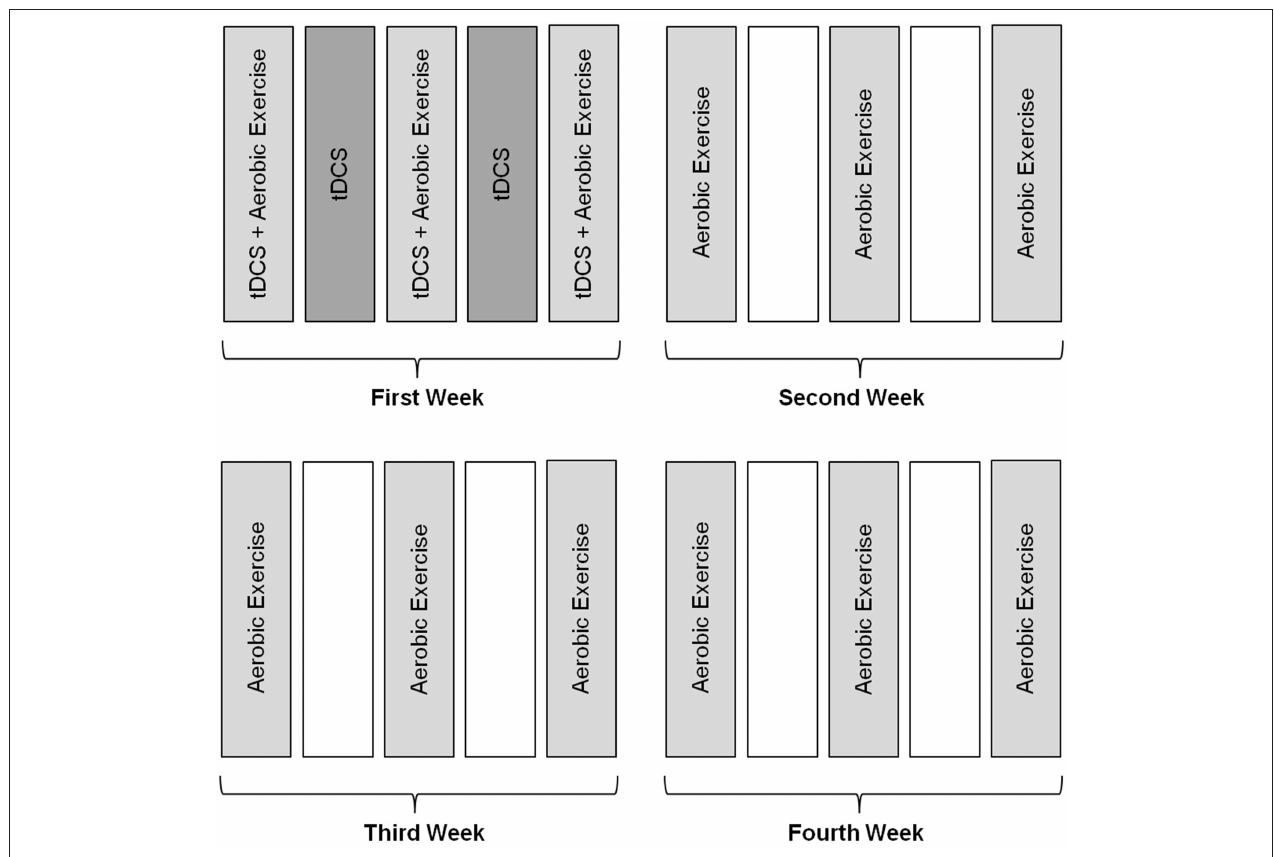
FIGURE 2 | Methodology of intervention. Subjects received intervention with tDCS during the first week for five consecutive days, associated with aerobic exercise training performed three times a week for a month.